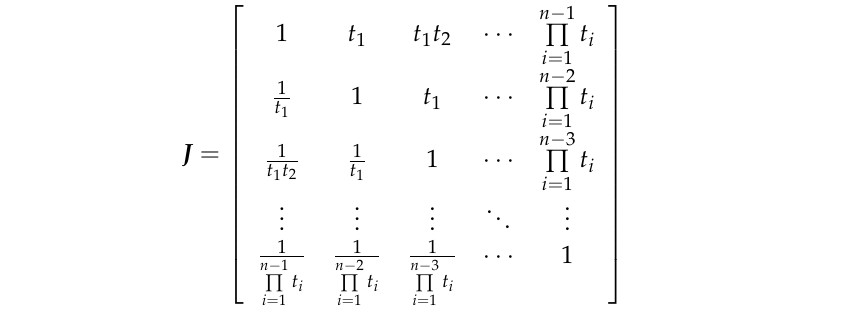
Table 1. Scale values between adjacent indexes. Scale Value 1.0 Equally Important 1.6 Obviously Important 1.2 Slightly Important 1.8 Absolutely Important 1.4 Strongly